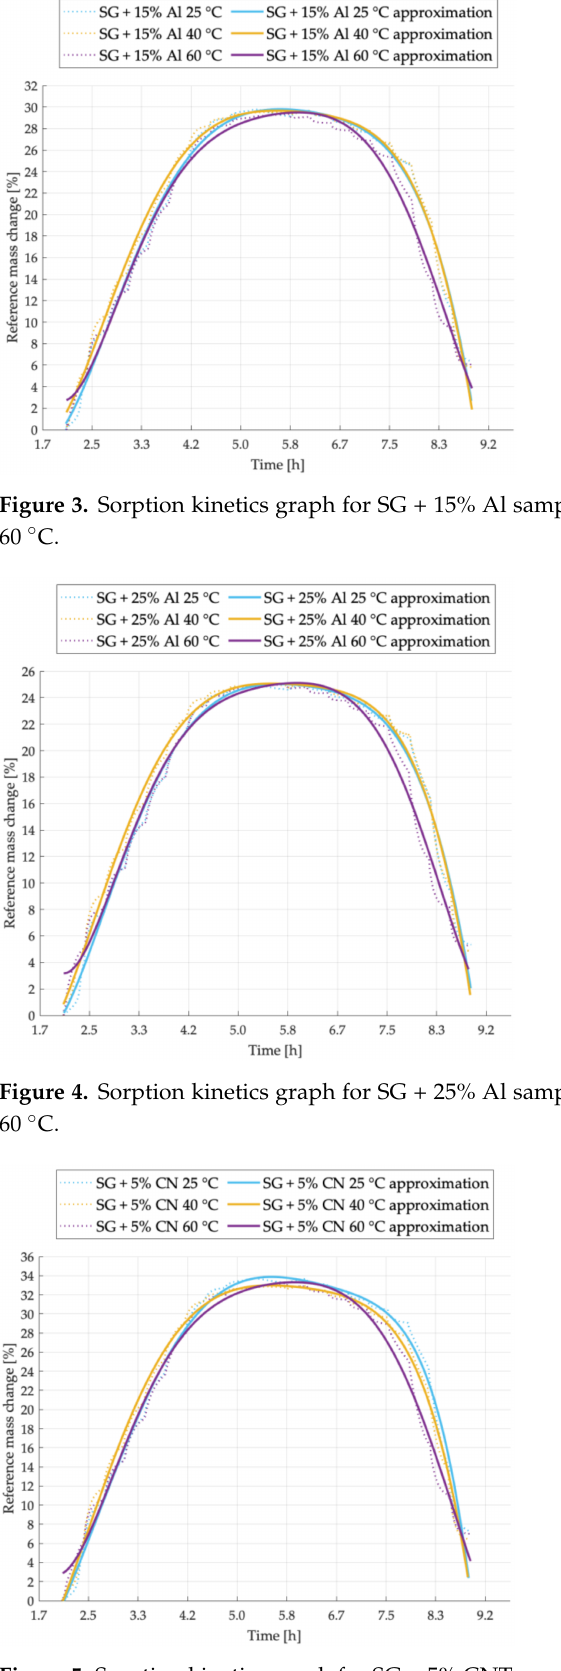
Figure 5. Sorption kinetics graph for SG + 5% CNT sample tested at temperatures of 25 ◦ C, 40 ◦ C, 60 ◦